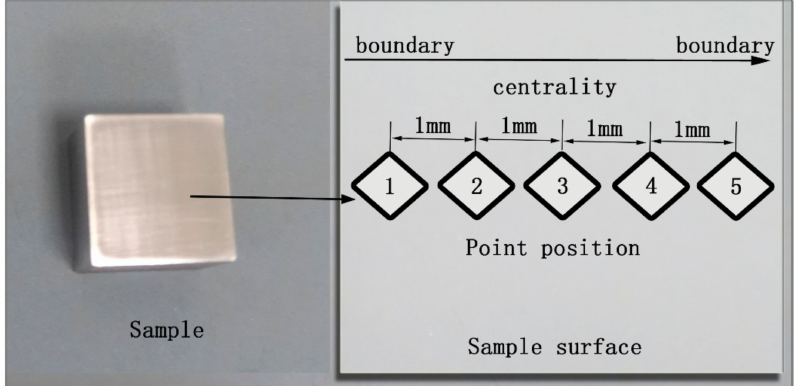
Figure 11. Schematic diagram of Vickers hardness.